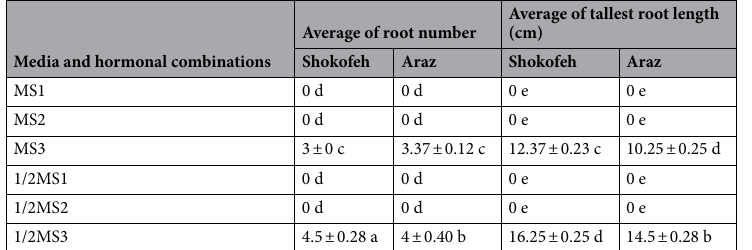
Average of tallest root length